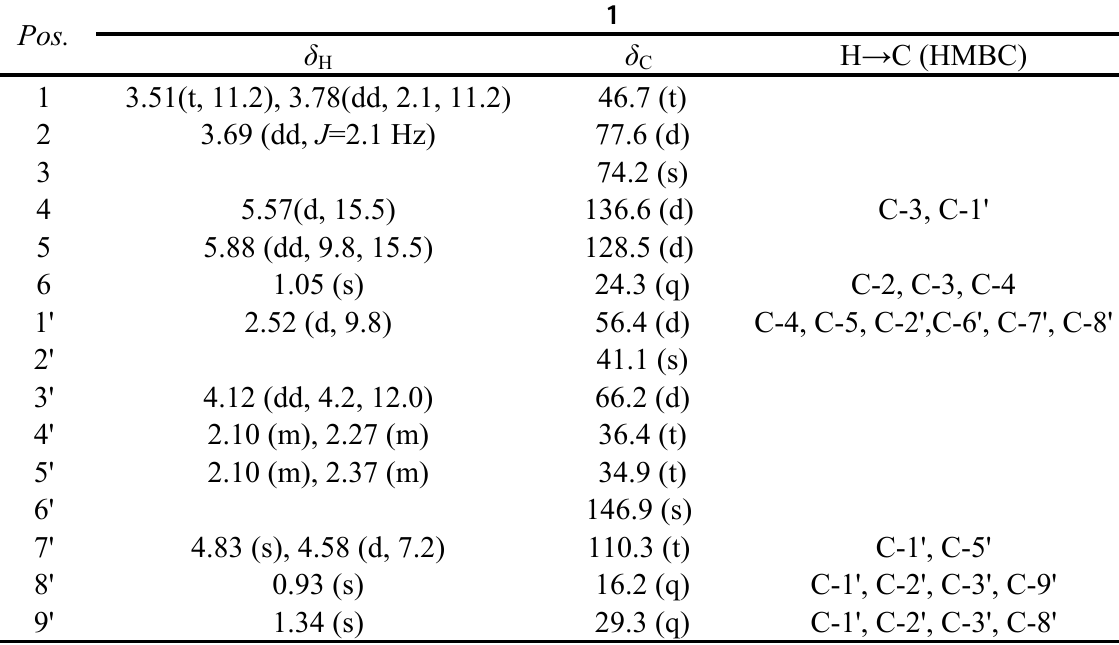
Table 1 . 1 H- and 13 C-NMR Data of 1 . NMR data were measured at 500 MHz for proton for 1 ( δ in ppm, J in Hz.) . Assignments and at 125 MHz for carbon in CDCl 3